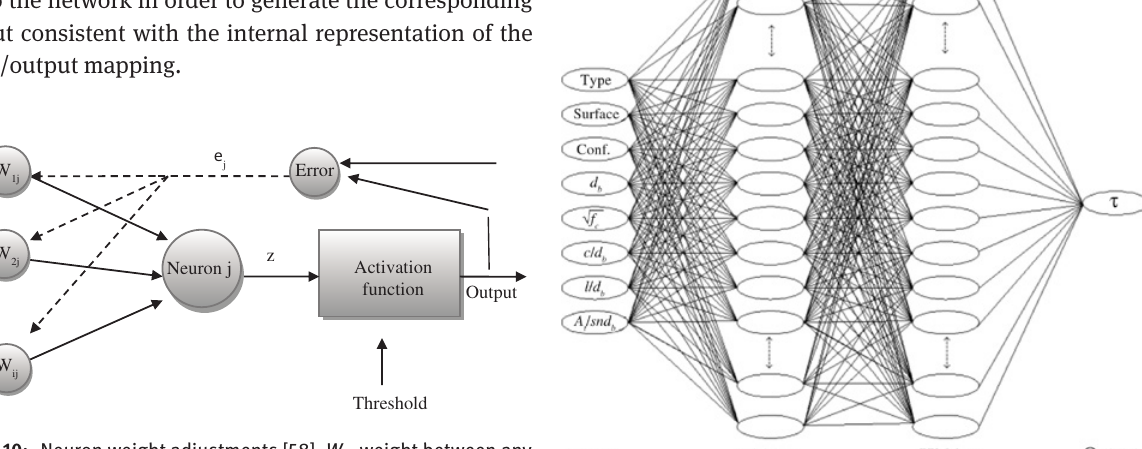
Figure 10: Neuron weight adjustments [58]. W = weight between any two nodes ( Dwn and Dwn − 1 are the modifications in the weight at n and n – 1 iteration). g = learning rate. Figure 11: Architecture of the proposed ANN